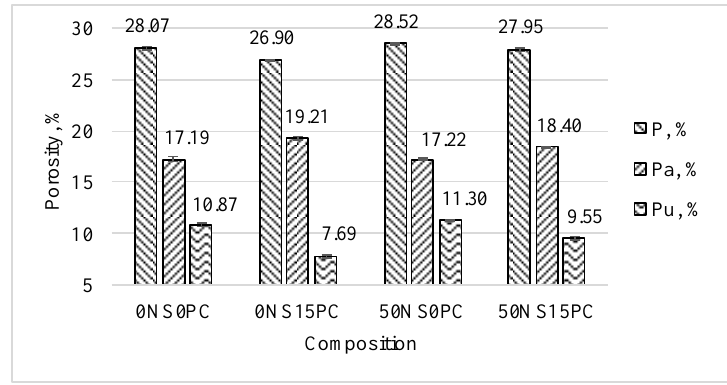
Figure 4. AAC samples porosity. P—total porosity; Pa—open porosity; Pu—closed porosity.